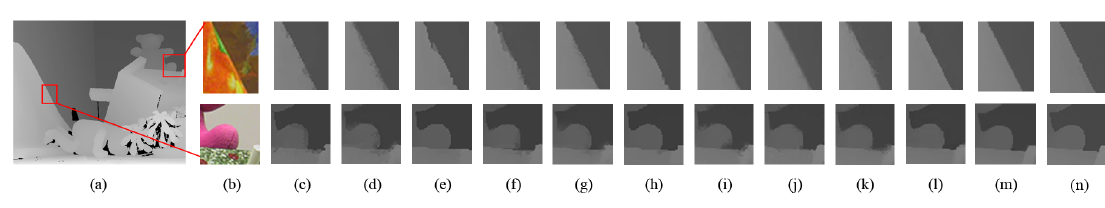
Figure 9. Example depth map SR results of Teddy with two ROI. ( a ) Ground truth depth map, ( b ) color regions, and SR results of ( c ) Diebel et al. [22] (BP% = 8.17) , ( d ) JBU [11] (6.61) , ( e ) Lu et al. [23] (5.60) , ( f ) Kim et al. [24] (6.20) , ( g ) Jung [17] (5.65) , ( h ) Lo et al. [3] (3.69) , ( i ) Park et al. [26] (5.24) , ( j ) Ferstl et al. [27]